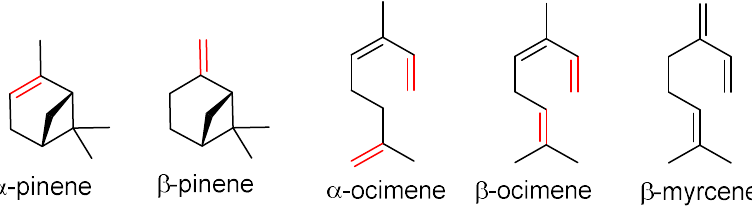
Figure 3. Structures of the active components from Laurus nobilis oil and Juniperus oxycedrus ssp. Oxycedrus oil.